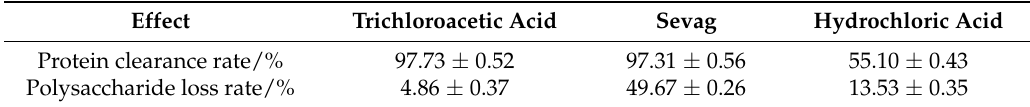
Table 1. Deproteinization effects by different methods in ACP.